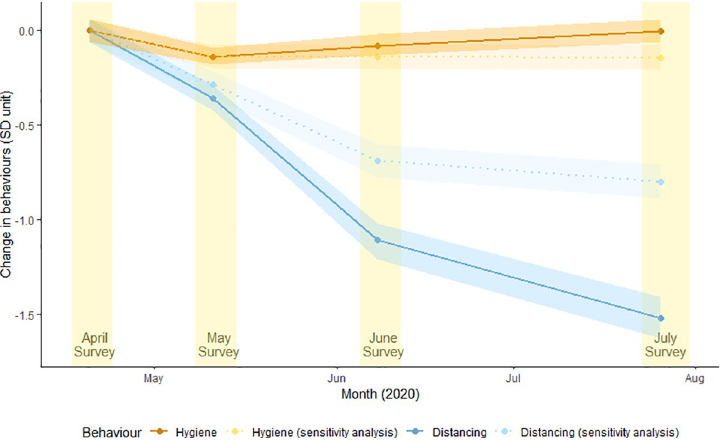
Fig 2. Change in distancing and hygiene behaviours between April and July, relative to April Survey variance (SD unit). Units refer to standard deviation of baseline behaviours (hygiene and distancing). The sensitivity analysis did not include the ‘staying at home’ behaviour in the PCA model.